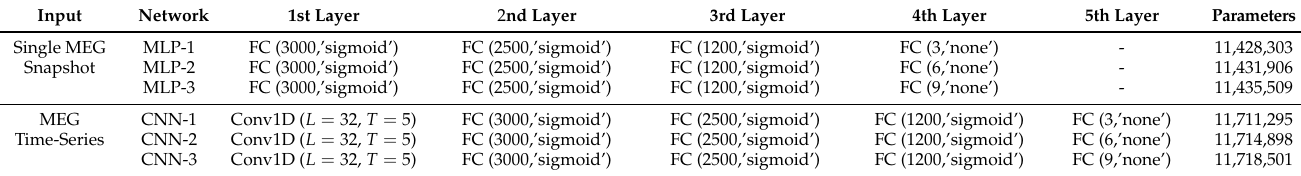
Figure 2. Illustration of the MLP-based MEG source localization solution. The end-to-end inversion operator performs mapping from the MEG measurement space to the source locations space. Table 1. Evaluated DeepMEG Architectures. Fully-connected layers are denoted by FC( N ,’activation’), where N is the number of perdeptrons and the activation function is Sigmoid for all layers excluding output layers, which compute sources locations and do not employ an activation function. Convolutional layers are denoted by Conv1D( L , T ), where L is the number of 1D kernels, and T is the length of each 1D kernel.